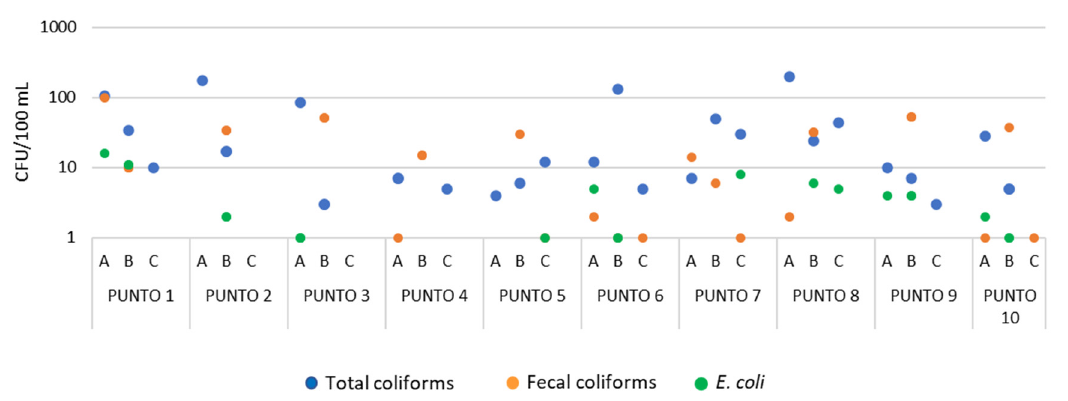
Figure 4. Abundance of coliforms in the ten sampling points.